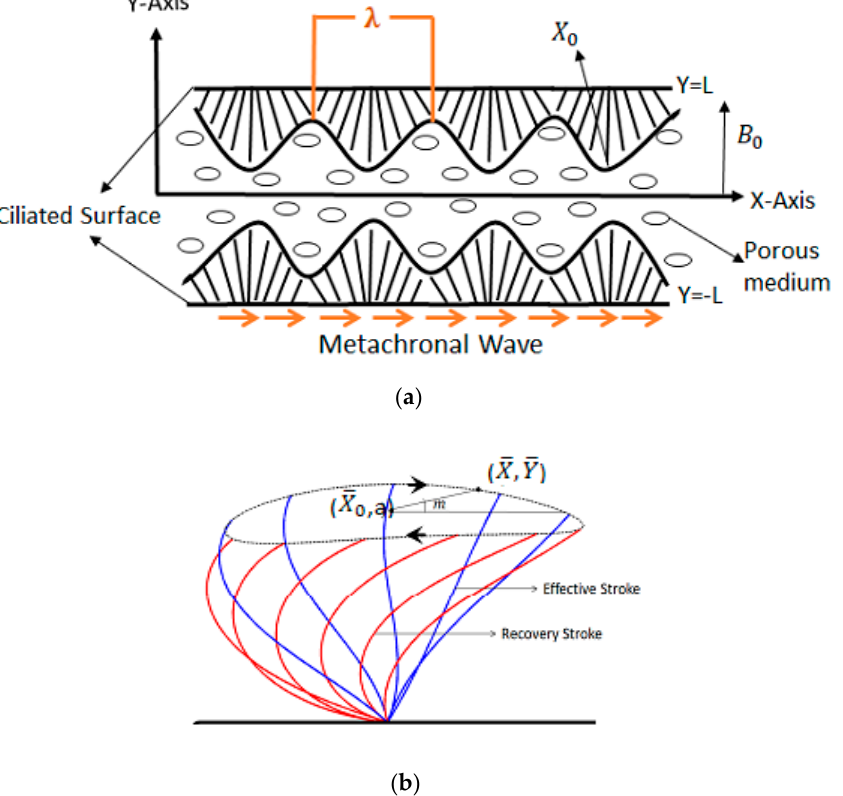
Figure 1. ( a ) Geometry of the channel with the ciliated bed; ( b ) recovery and effective stroke of a single cilium forming an elliptical